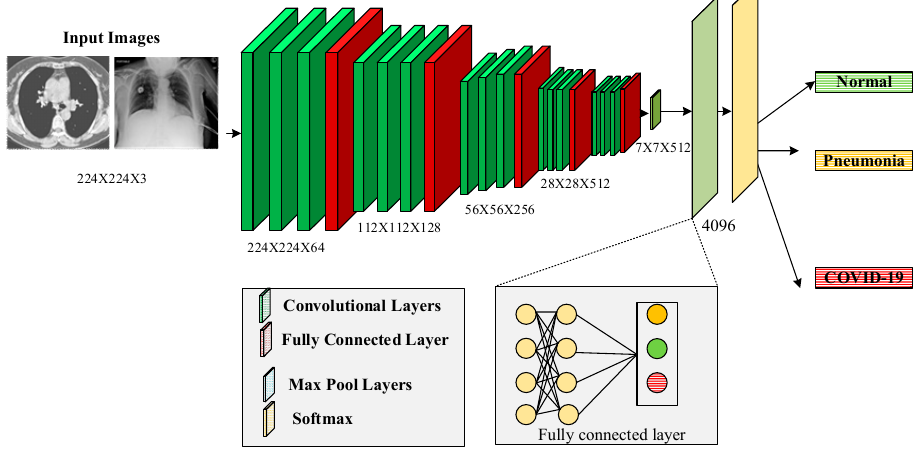
Figure 3. The architecture of VGG 16. Table 1. Features and Aesthetics of the